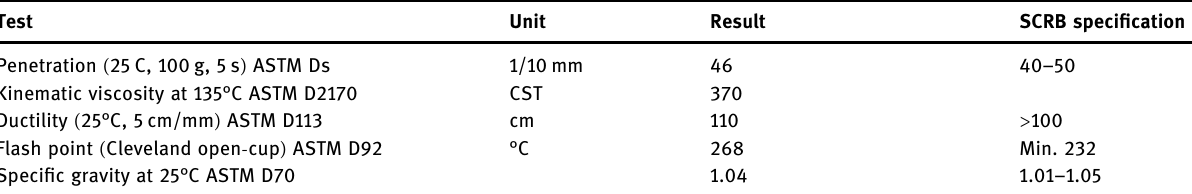
Table 1: Physical properties and tests of asphalt cement